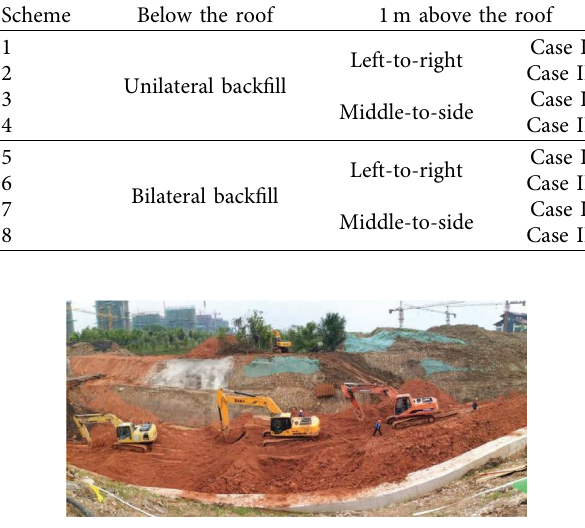
Figure 5: Excavation site of the river-crossing section.